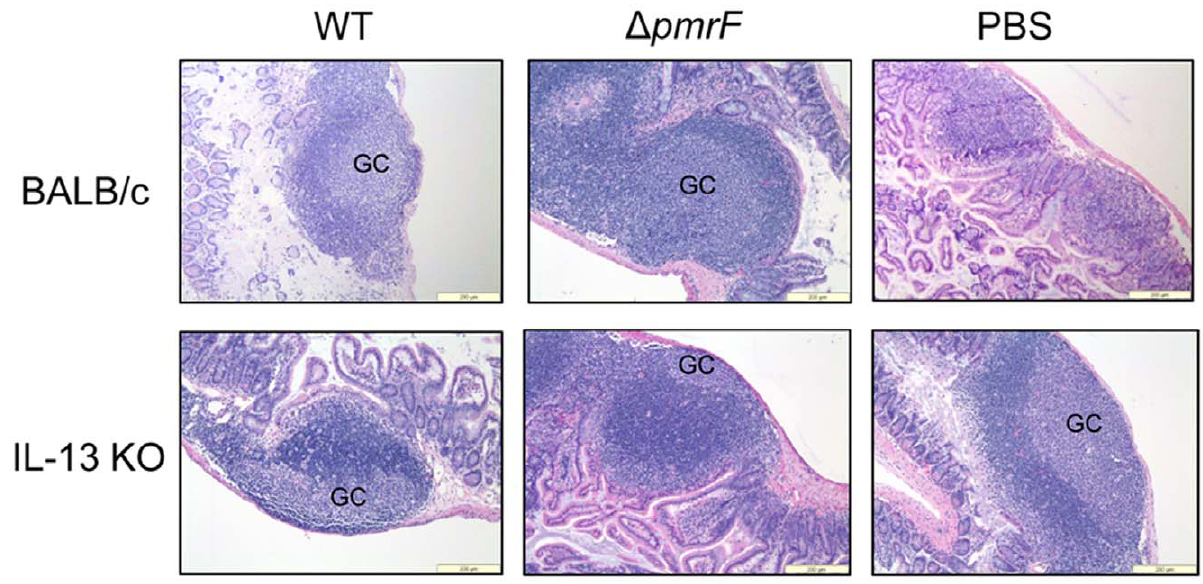
Figure 8. Histology of BALB/c and IL-13 KO Peyer’s patches infected with WT or D pmrFS. Typhimurium. Hematoxylin and Eosin staining of Peyer’s patches infected orally with 10 8 CFU of WT or D pmrF S. Typhimurium, or mock-infected with PBS for 48 hrs. GC- germinal